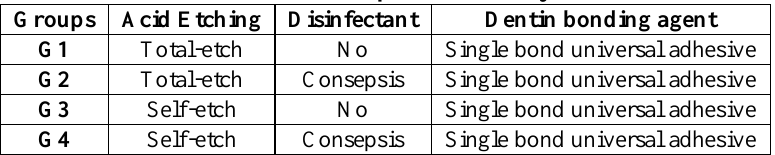
Figure 1: a diagram showing the dimensions of cavity design used in this study. Cavity preparation was made by using diamond round bur (REF S6801, Komet, Germany) and a parallel sided flat-ended diamond fissure bur (REF S6835, Komet, Germany), both with a high speed and water cooled hand piece (NSK). The occlusal portion of the preparation had a facio- lingual width of 2 mm. the gingival floor of the proximal box was kept 1mm below the cemento- enamel junction to keep the gingival margins in dentin (1) . Each preparation was rinsed for 20 seconds with distilled water and dried with blast of compressed air for 5 seconds. Caution was taken not to over dry the preparation. The samples were randomly distributed in to four experimental groups, each consisting of 10 cavities. All the Table 1: Groups of this